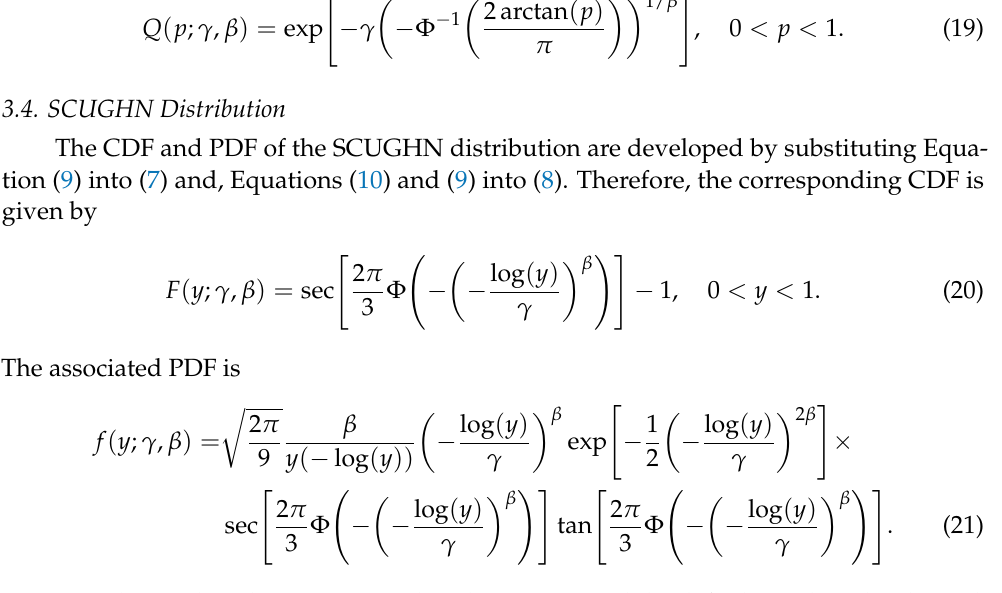
Figure 4 shows that the SCUGHN distribution can exhibit left-skewed, right-skewed, reversed-J, and bathtub shapes for some given parameter values. The SCUGHN distribution shows similar shapes to the CUGHN